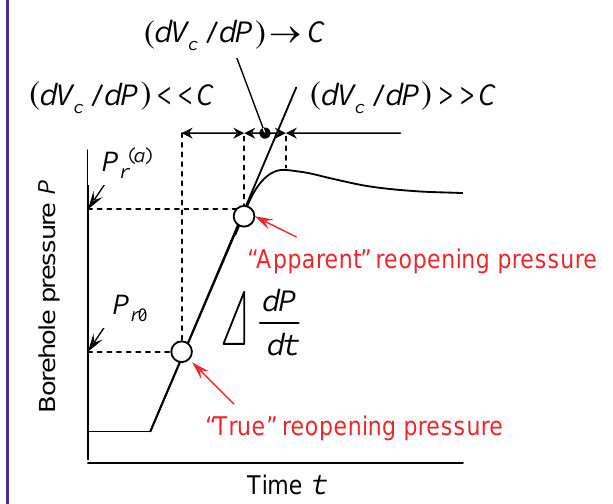
Figure 1. Effect of the system compliance C and fracture opening on borehole pressure